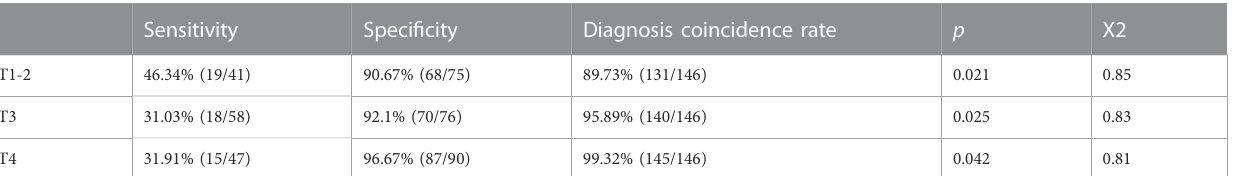
TABLE 3 Diagnostic coincidence rate, sensitivity, and speci fi city of MR staging.